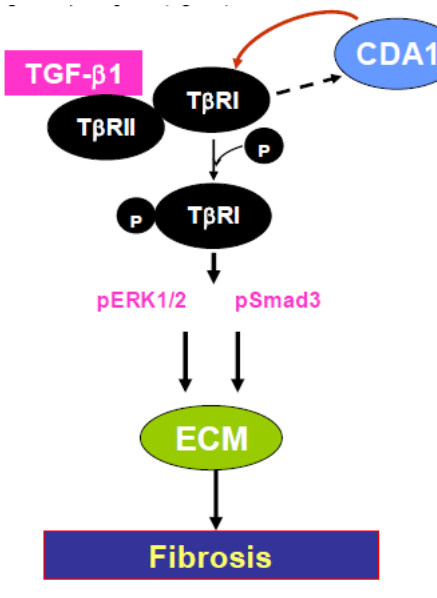
Figure 4. Schematic representation of the promotion of fibrosis arising from cross-talk between CDA1 and TGF-